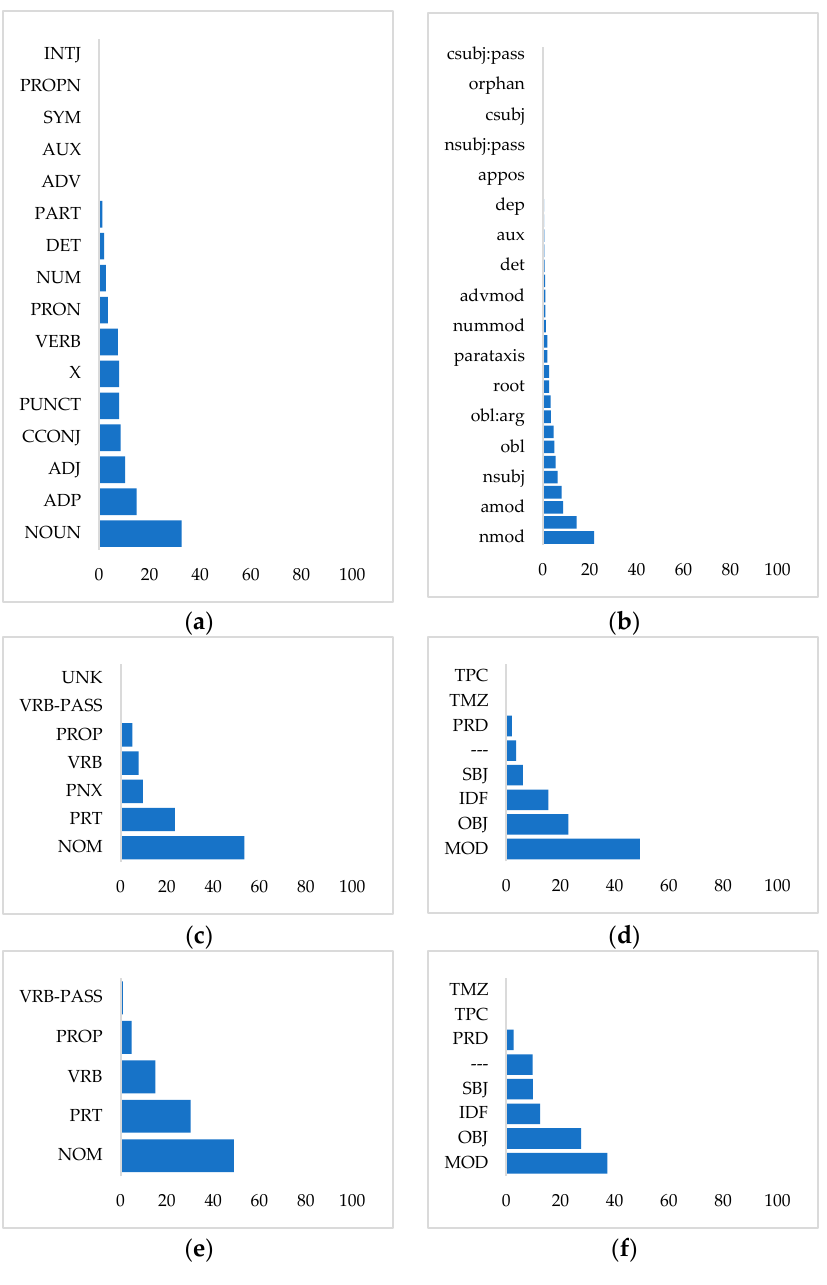
Figure 3. Distributions of POS tags and dependency relations labels (DRs). ( a ) PADT—POS. ( b ) PADT—DR. ( c ) CATiB—POS. ( d ) CATiB—DR. ( e ) ArPoT—POS. ( f )